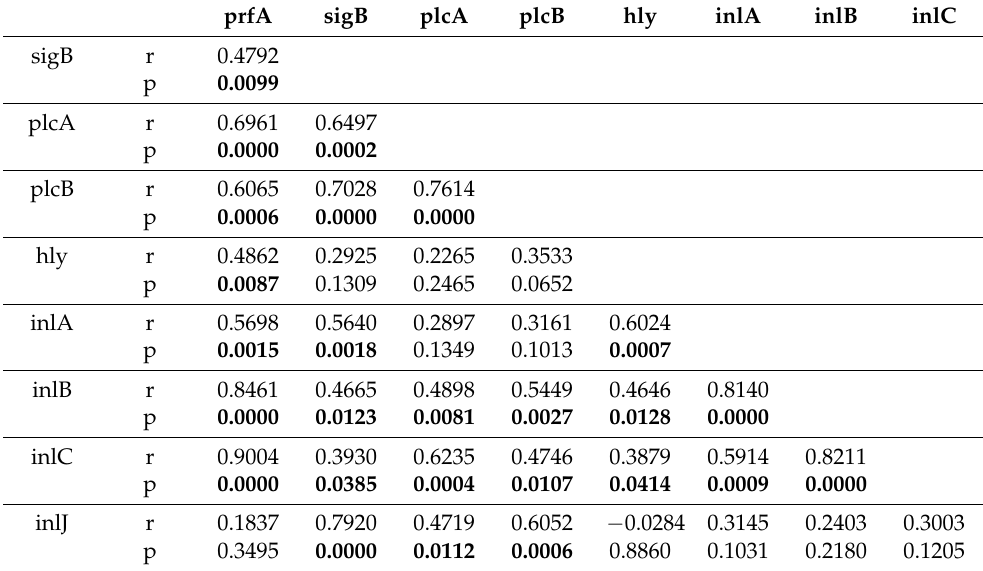
Table 3. Pearson product moment (r) correlations between the relative transcription of each pair of